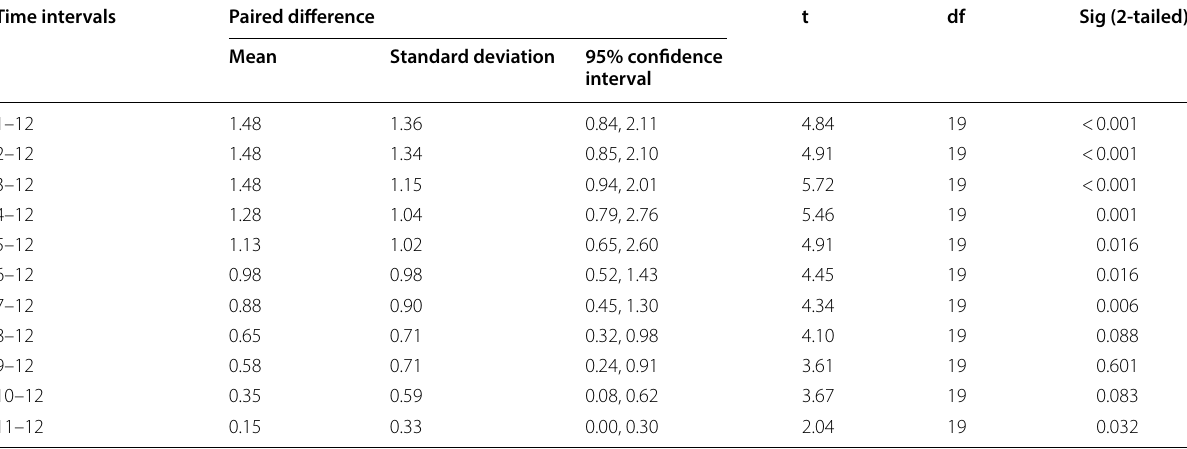
Table 3 EDSS scores in the study group in each time intervals Time